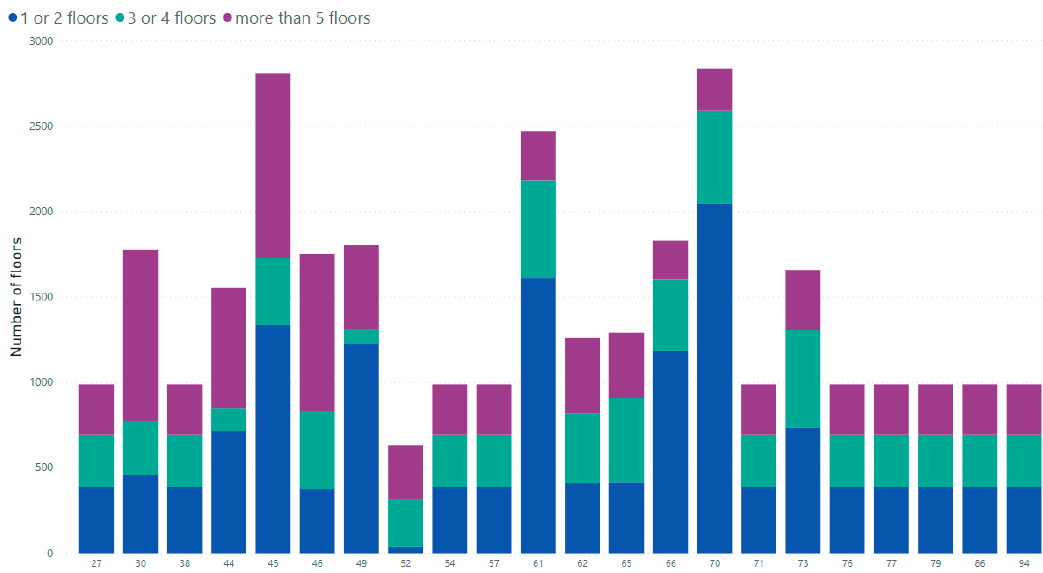
Figure 10. Distribution of types of incidents by number of floors, based on the building age.